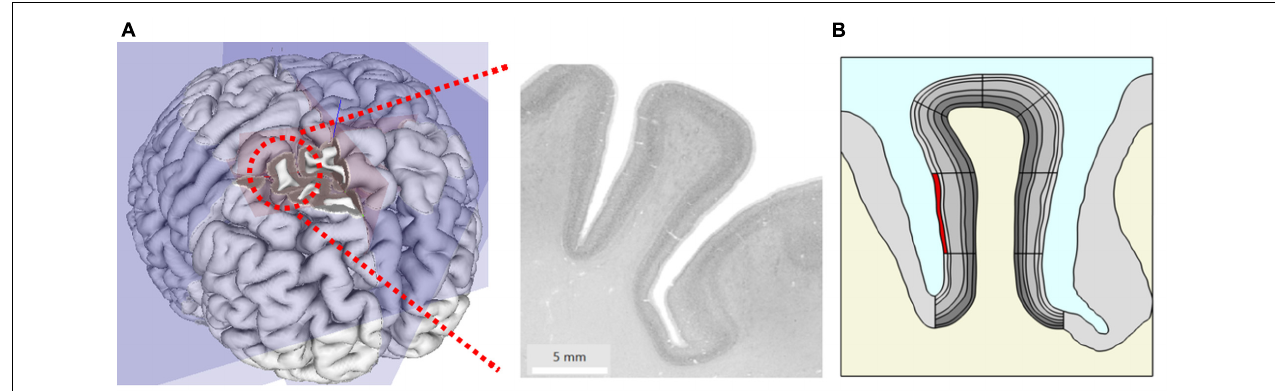
FIGURE 1 | (A) Original microscopy image of the right middle frontal gyrus at MNI coordinate x = 24 mm, y = 30 mm, z = 41 mm taken from the HumanBrainProject. (B) The geometric model extracted from (A) showing gray matter (GM) (gray) with different anatomic layers (different gray levels), white matter (WM) (cream) and cerebrospinal fluid (CSF) (blue). Simulation of local changes in tissue mechanics: the stiffness and volume of a segment of interest (here superficial layer L1 highlighted in red) were increased to simulate the effect of local increase in blood flow.